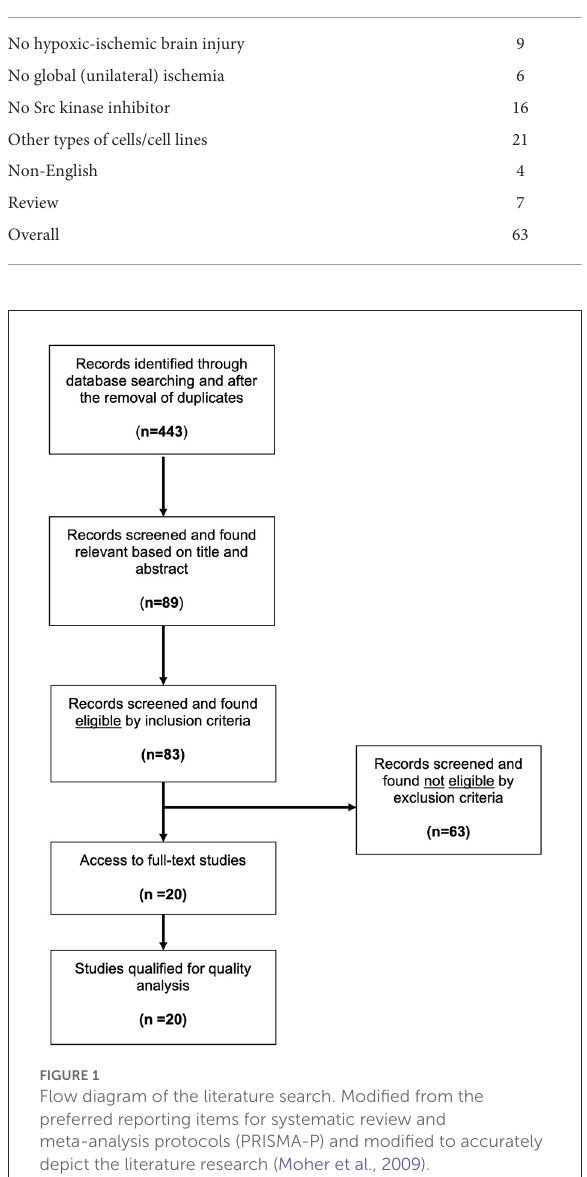
FIGURE1 Flow diagram of the literature search. Modified from the preferred reporting items for systematic review